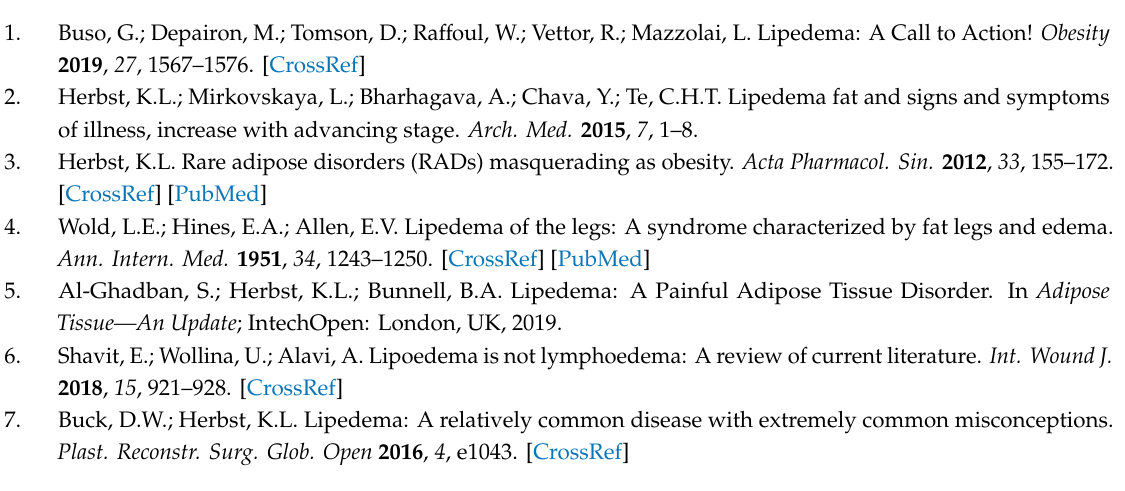
Figure S1: Quantitative analysis of alizarin red by spectrophotometry showing no di ff erence in the osteogenic di ff erentiation between healthy and lipedema ASCs-T or healthy and lipedema ASCs-A ( n = 4 per group). The results are displayed as scatter plots with bars. The values are the mean ± SEM; Figure S2: Flow cytometry analysis of SVFs. (A) SVFs showed a similar expression of stemness and surface markers between lipedema patients (SVF-A, n = 6; SVF-T, n = 8). (B) CD31 marker expression in SVFs showed a significant increase in lipedema patients compared to healthy patients (SVF-A healthy, n = 8; SVF-T lipedema, n = 6; SVF-A lipedema, n = 9). The results are displayed as scatter plots with bars. The values are the mean ± SEM. ** p < 0.01 *** p < 0.001; Figure S3: Quantitative analysis of CFU assay revealed a significant increase in the colony-forming potential of lipedema ASCs compared with healthy patients as well as a significant decrease between healthy ASCs-T and lipedema ASCs-A (ASCs-T: healthy n = 8 and lipedema n = 10; ASCs-A: healthy n = 9 and lipedema n = 8). Results are displayed as scatter plots with bar. Values are mean ± SEM. * p < 0.05, ** p < 0.01; Figure S4: Quantitative analysis of Oil Red O (A) and Alizarin red (B) by spectrophotometry showing a significant decrease in adipogenic and osteogenic di ff erentiation potential in lipedema ASCs-A compared to lipedema ASCs-T ( p < 0.05) and a significant decrease in the osteogenic potential in healthy ASCs-A compared to healthy ASCs-T, but no di ff erence was shown in their adipogenic potential (Adipogenic di ff erentiation ASCs-T: healthy n = 10 and lipedema n = 9, ASCs-A: n = 8 per group, Osteogenic di ff erentiation, n = 4 per